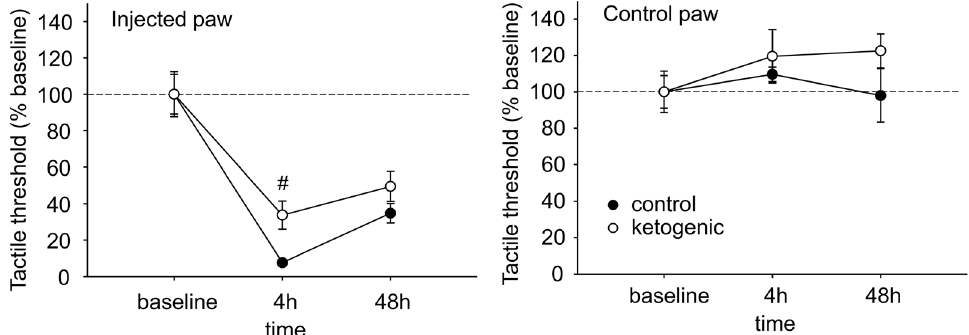
Figure 2. Effects of CFA and diet treatment on tactile allodynia in rats assessed by electronic von Frey probe. For the injected paw, all 4 h and 48 h groups are significantly different from baseline (not indicated). There were no treatment effects on control paw sensitivity. Control n = 14, ketogenic n = 12. # p < 0.05 control v. ketogenic diet.